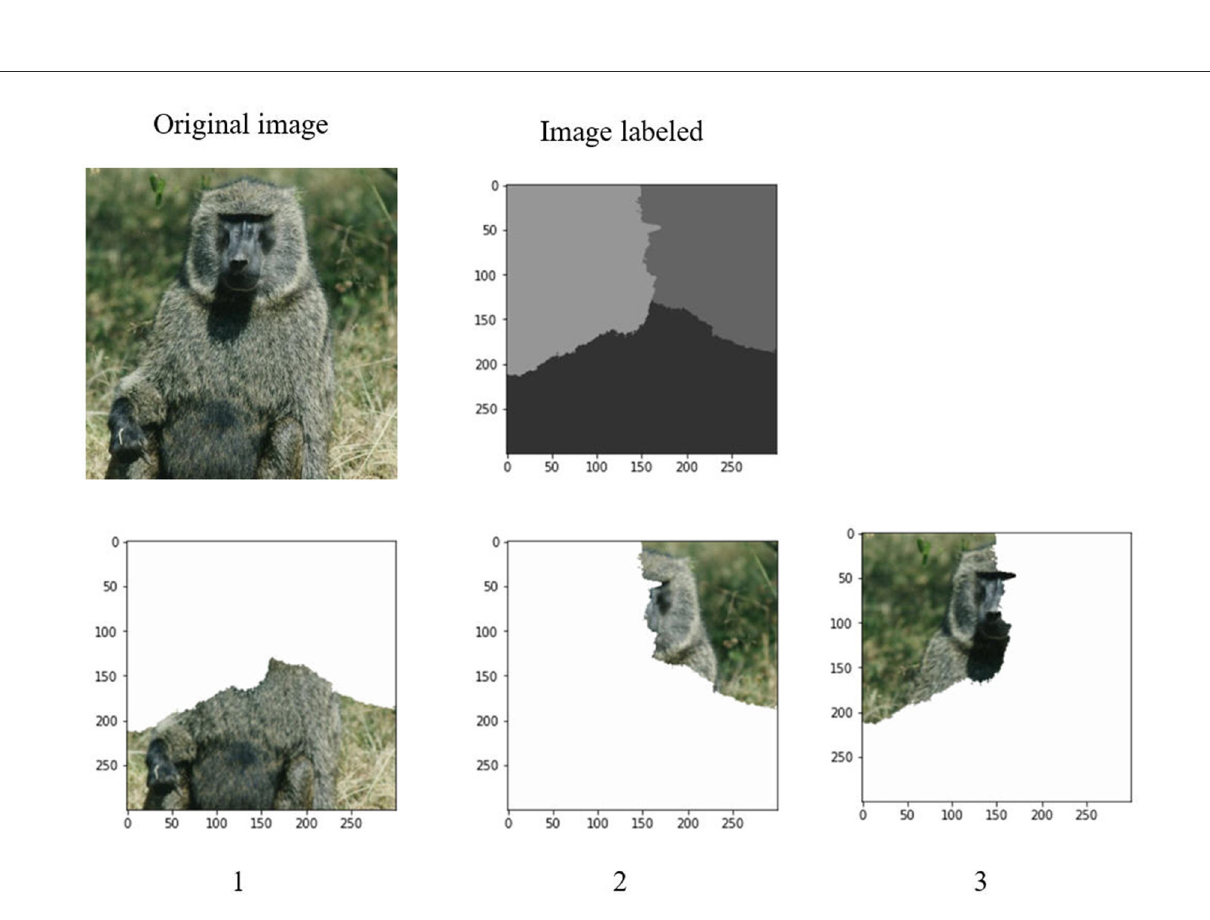
FIGURE6 Grouping on the eigenvalue by k-mean to k